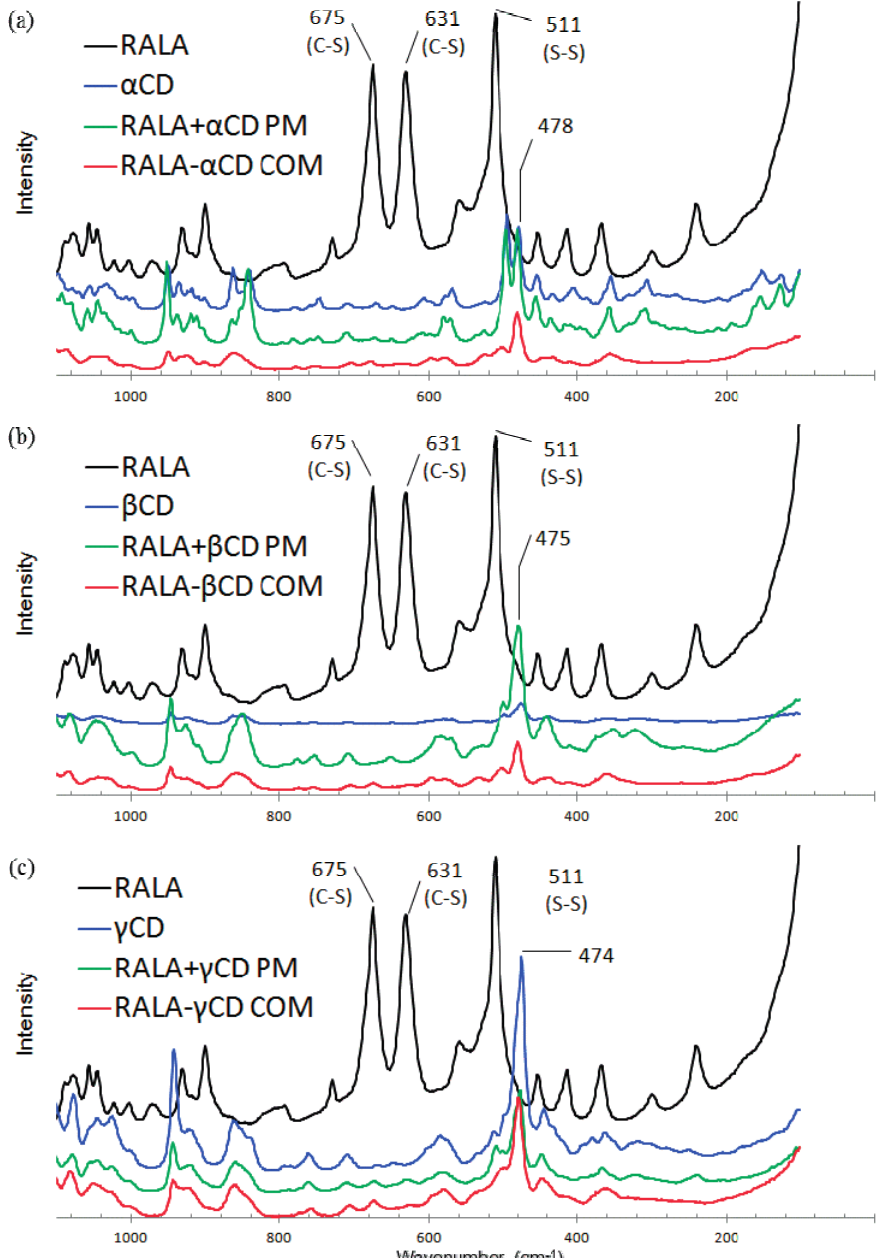
Figure 7. Raman spectra of RALA-CD complexes. (( a ) α -CD; ( b ) β -CD and ( c ) γ -CD) (COM: Complex, PM: Physical